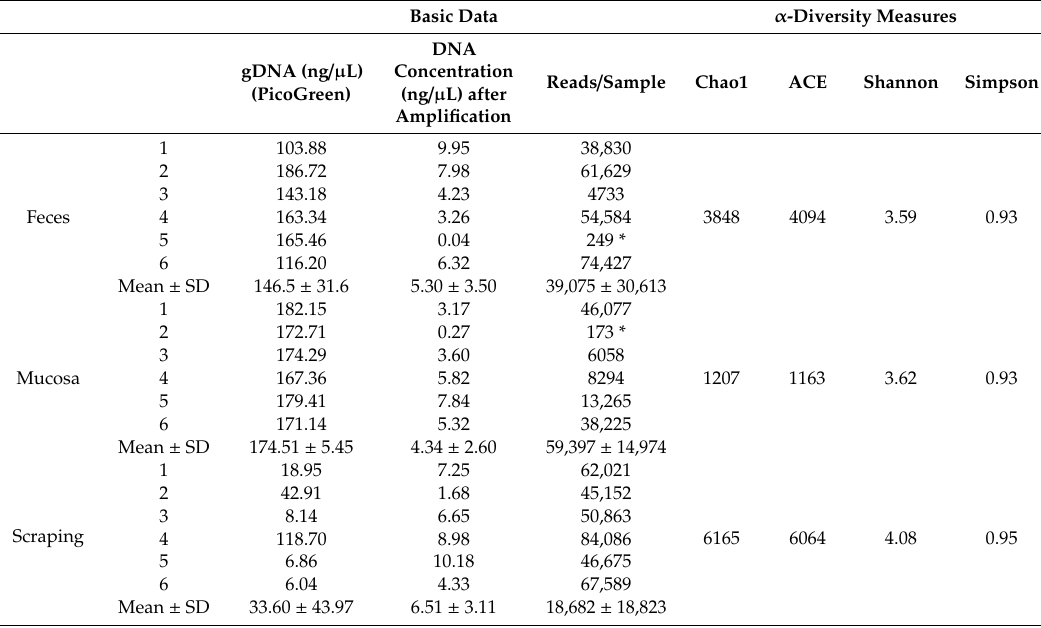
Table 2. DNA, amplicon yield, amount of high-quality reads and α -diversity measures in samples collected from di ff erent compartments (Step